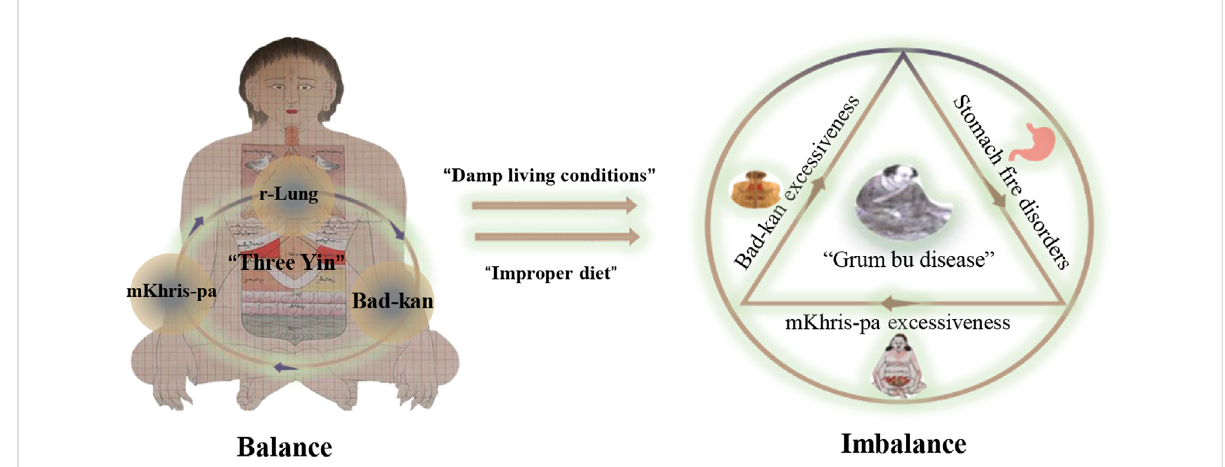
FIGURE 1 Pathological process of the “ Grum bu disease ” in Tibetan